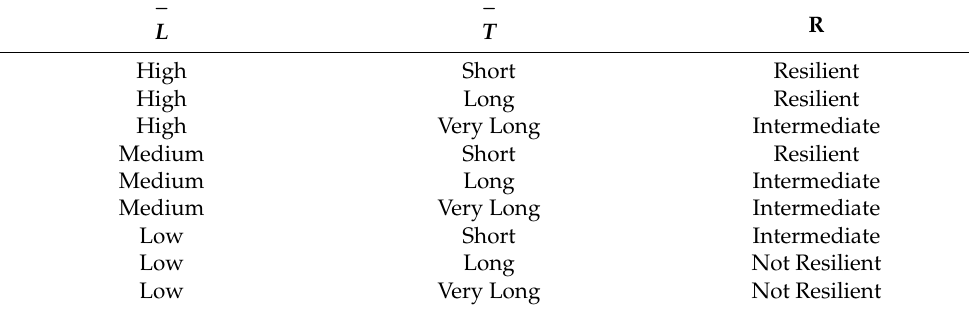
Table 5. Fuzzy rules using three terms for each variable.